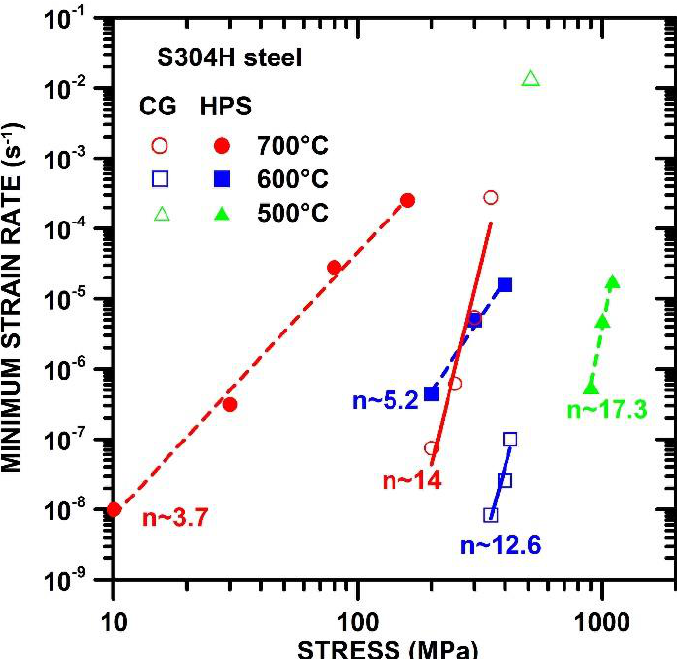
Figure 5. Stress dependences of minimum creep rates determined at 500 °C, 600 °C and 700 °C for CG and HPS-processed state.